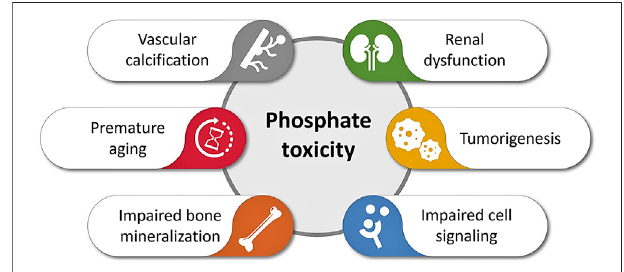
FIGURE 2 | Simpli fi ed diagram illustrating various adverse events of phosphate toxicity, ranging from impaired bone mineralization to vascular calci fi cation to accelerated aging (inspired based on earlier publications) (Akimbekov etal.,2022;Razzaque, 2022a;Eremetal.,2022; Michigami et al., 2022; Nakatani et al.,